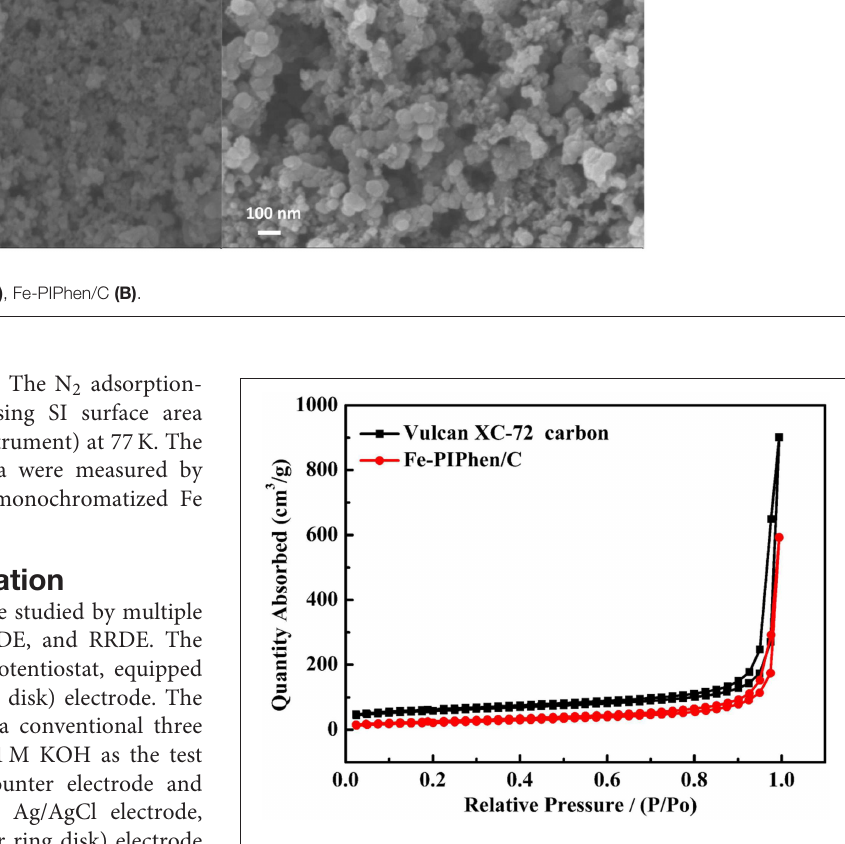
FIGURE 3 | The isotherms of Vulcan XC-72 (black line), Fe-PIPhen/C (red line) during the adsorption/desorption of nitrogen gas.